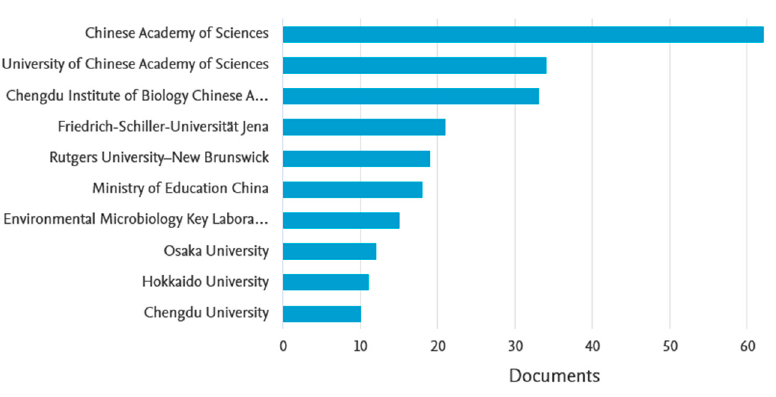
Figure 6. The most productive institutes/universities within the studied research domain. In total, the authors affiliated with China published 132 articles; those affiliated with the USA were in the second position (69); and those affiliated with India were in the third position (42) (Figure 7).